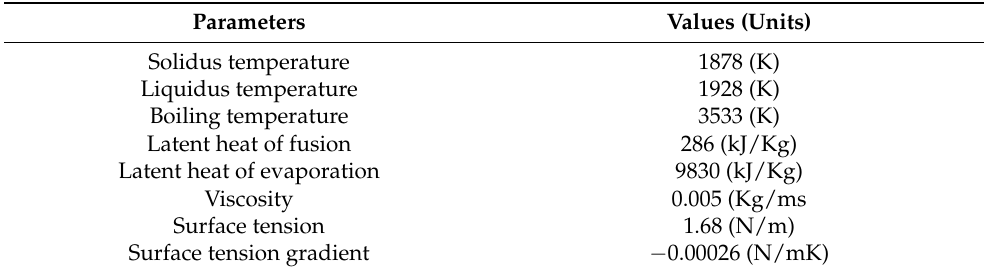
Table 1. The thermo-physical properties of Ti6Al4V [49].